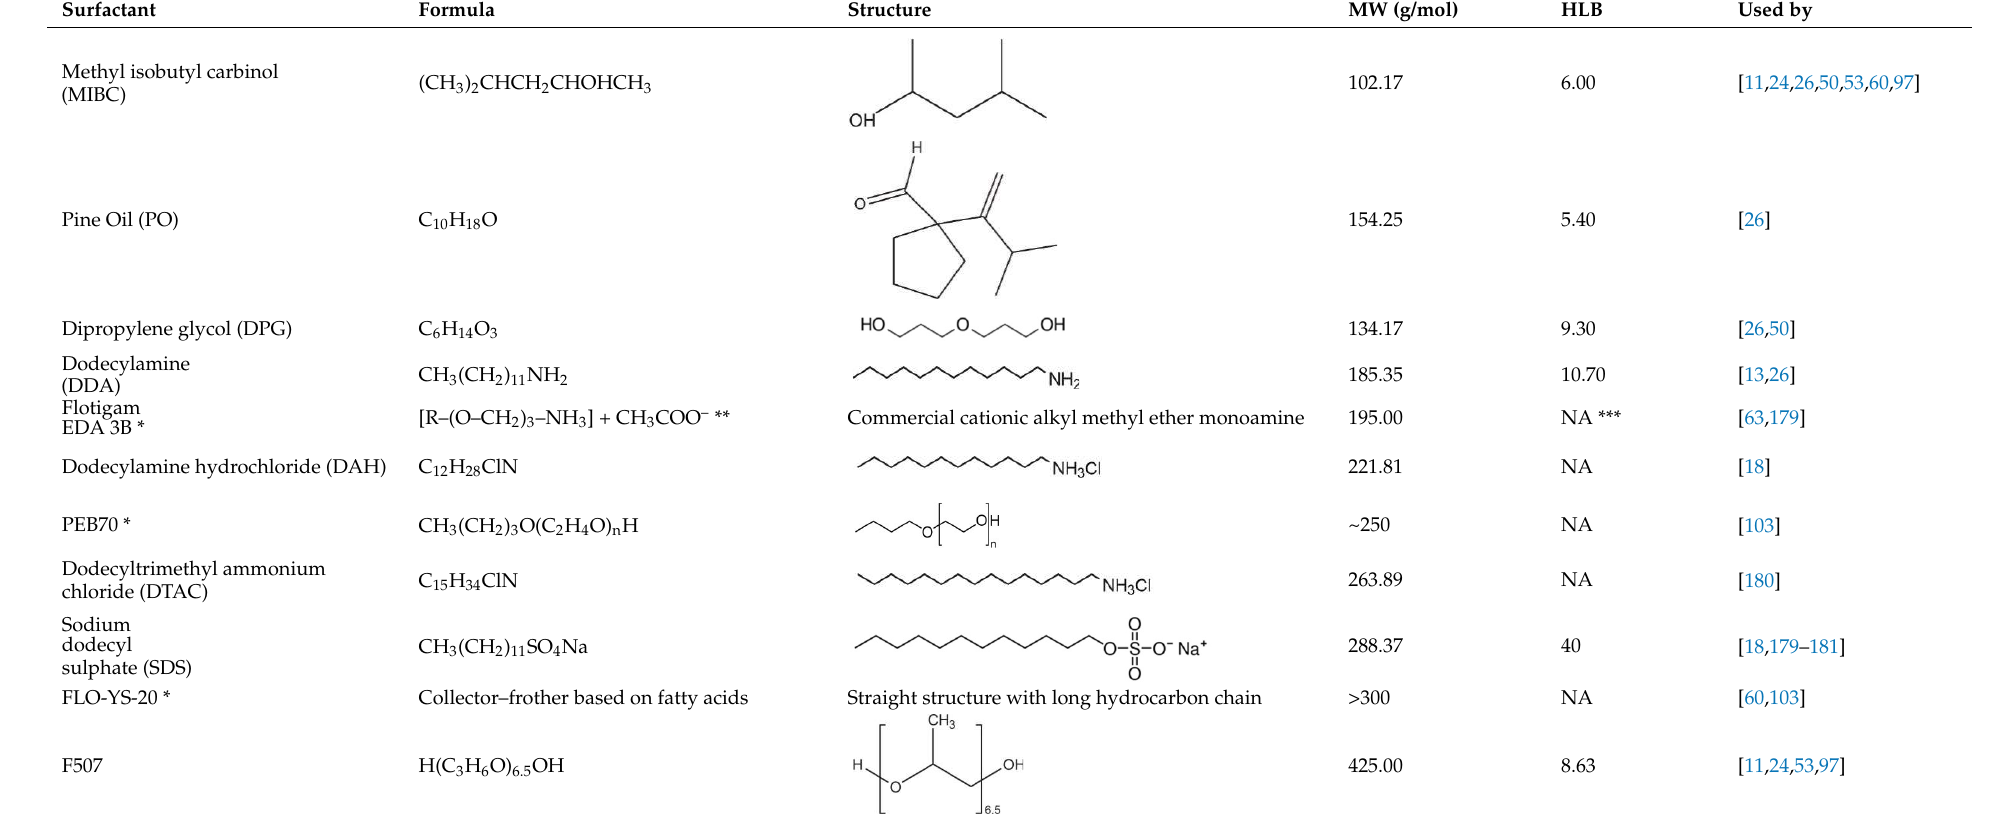
Table 3. Physiochemical properties of surfactants used for NBs generation.